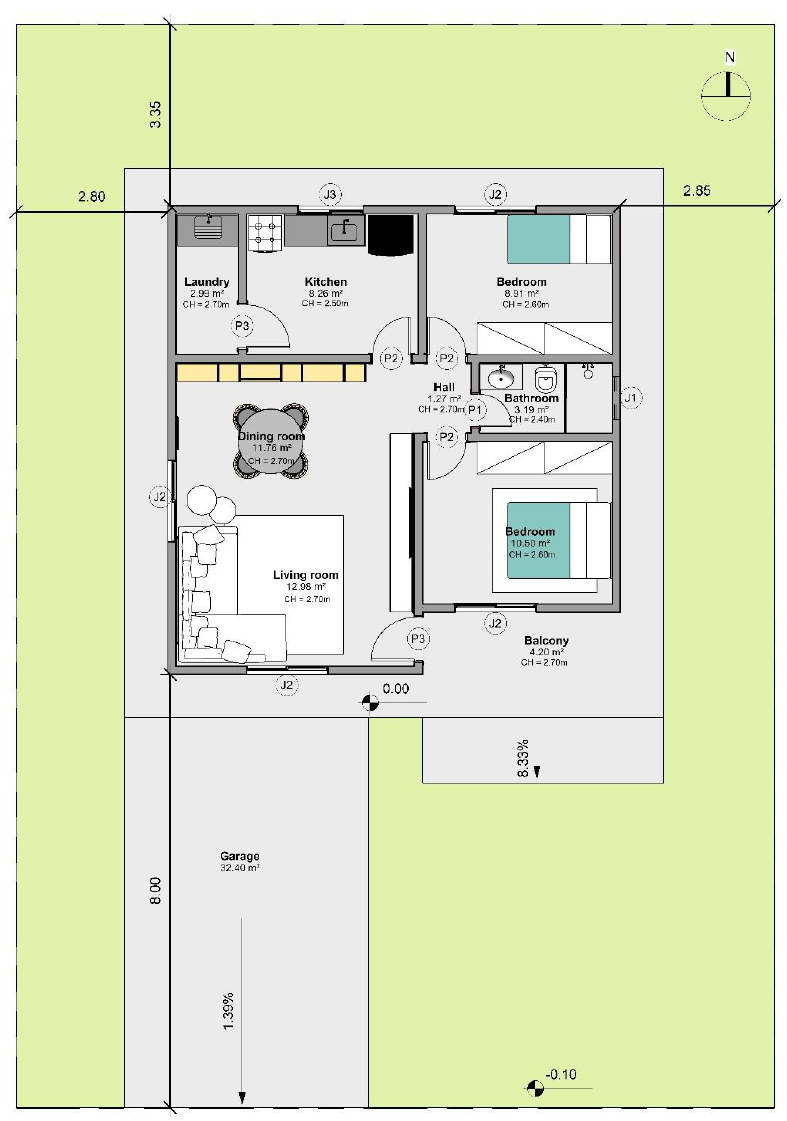
Figure 3. Single-family case study floor plan (in metres).